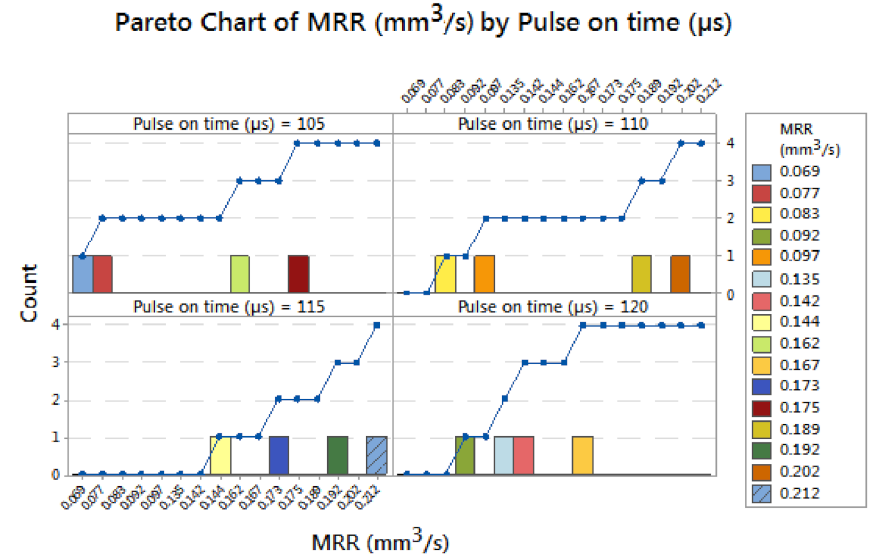
Figure 4. Pareto chart of material removal rate by pulse on